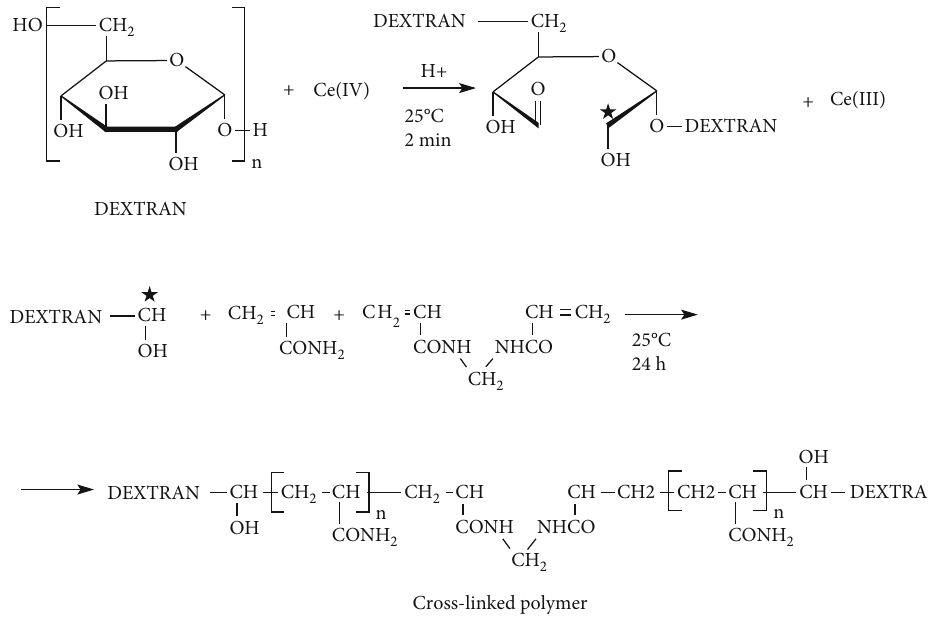
Figure 1: The proposed mechanism of the synthesis of cross-linked D-g-PAA hydrogels.